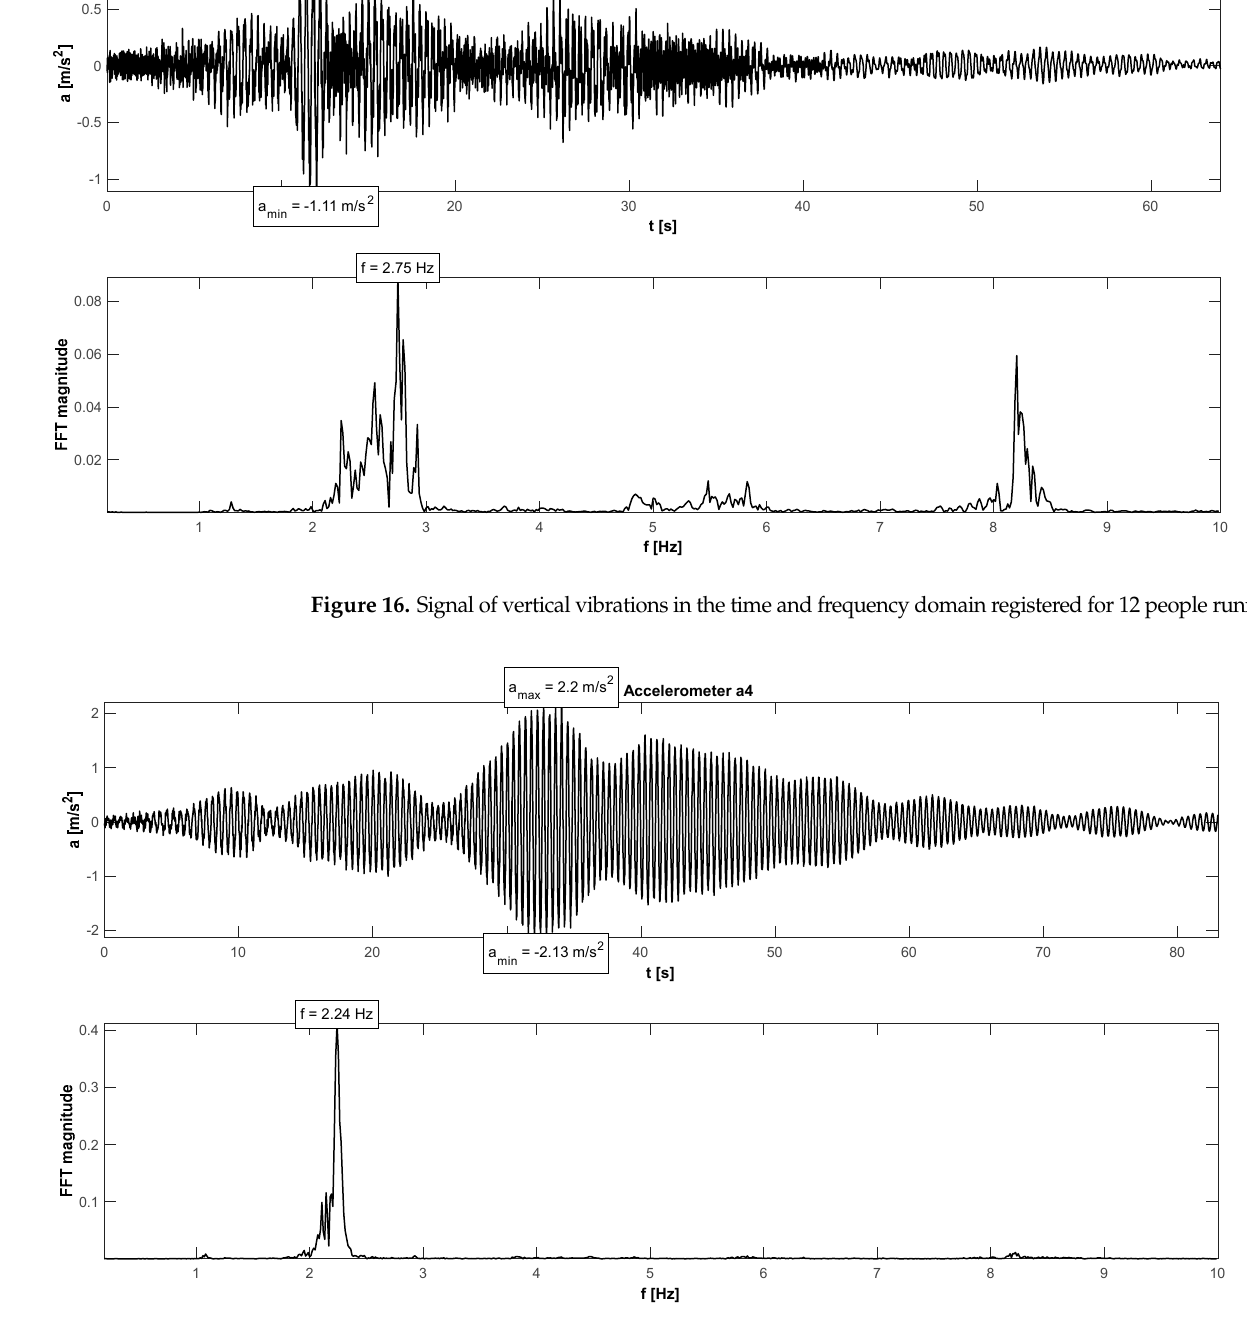
Figure 17. Signal of vertical vibrations in the time and frequency domain registered for the synchronized walking of 12 people.